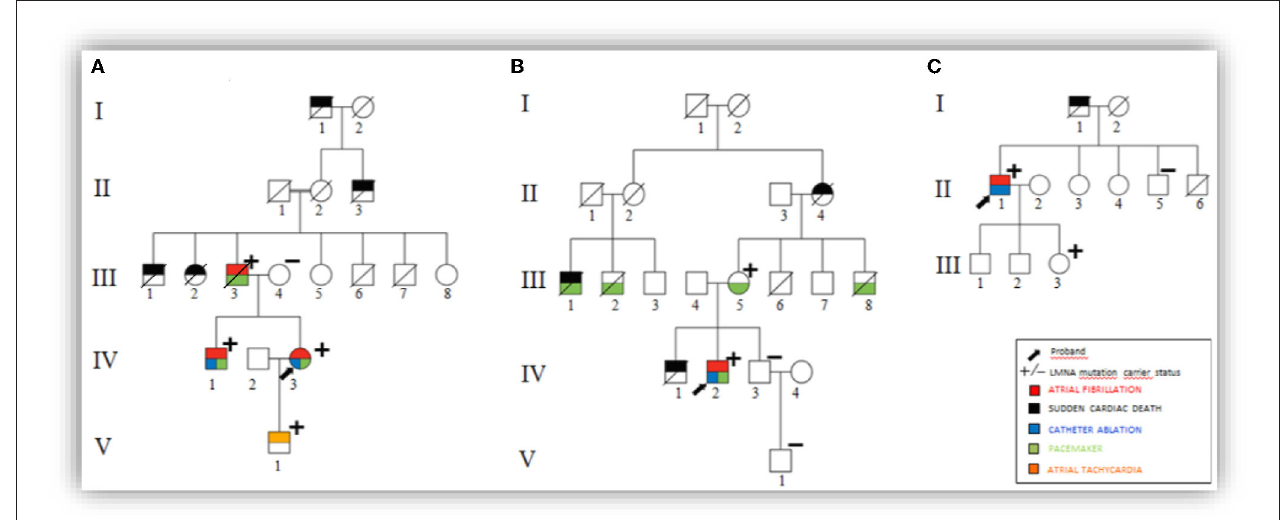
FIGURE 2 | Pedigrees with variant segregation data. (A) Pedigree from Family A. (B) Pedigree from Family B. (C) Pedigree from Family C.